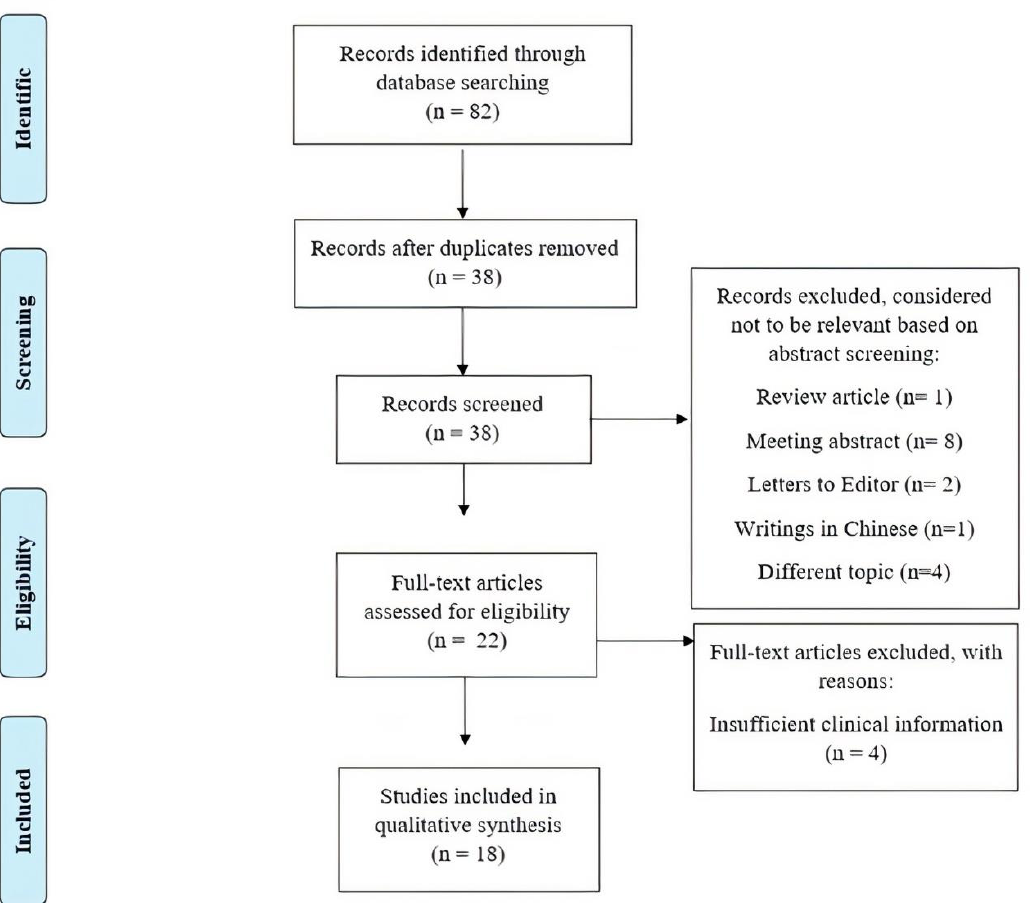
Figure 2. PRISMA flow diagram of search yield, screening and inclusion steps.